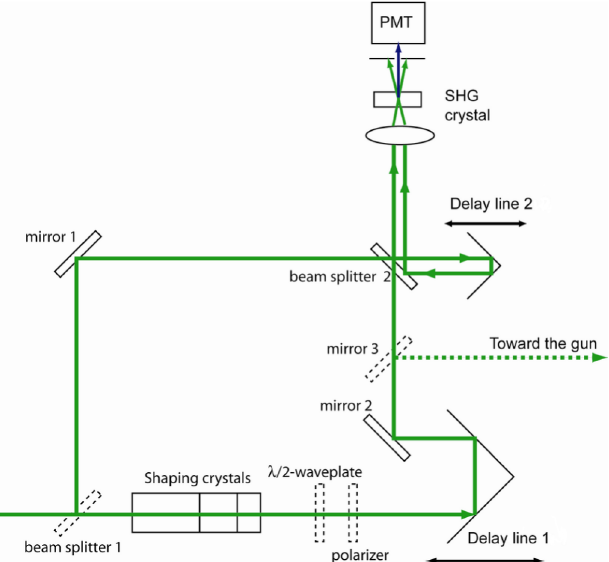
FIG. 3. (Color) Cross-correlator setup. Beam splitter 1 (BS1) and mirror 3 (M3) are on flipper mounts. When cross correlation is measured, BS1 is flipped up, M3 is flipped down, and the polarizer and the half-waveplate are inserted. When the laser beam drives the gun, BS1 is down, M3 is up, the wave plate and the polarizer are removed. Delay line 1 is used to set the time scale of the deflector cavity and the cross between 6 : 3 (cid:7) 10 18 and 1 : 9 (cid:7) 10 19 cm (cid:4) 3 were activated in